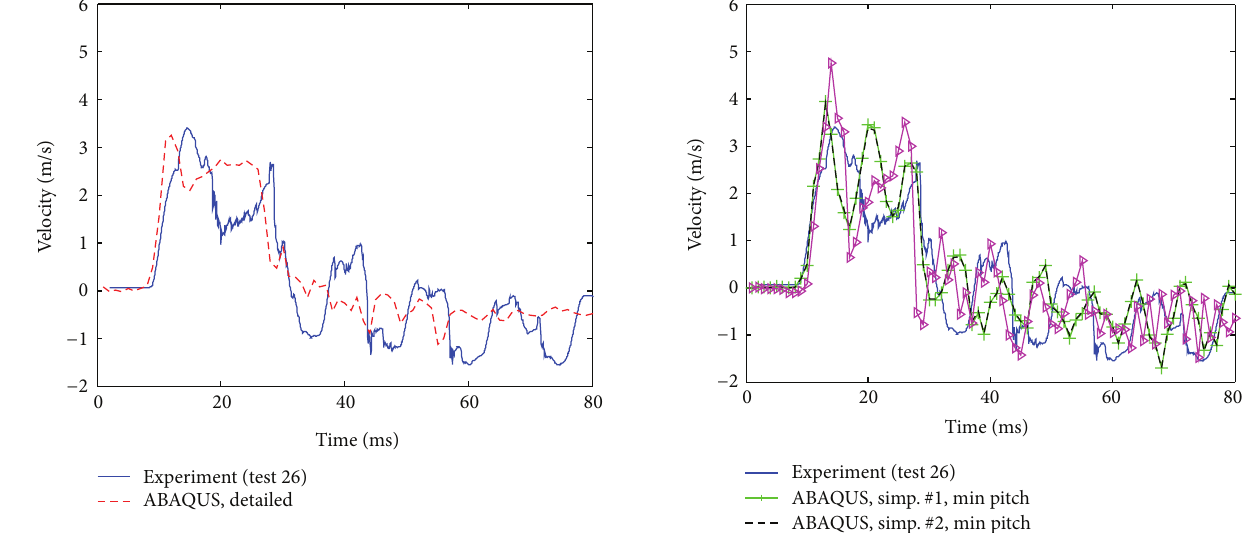
Figure 14: Velocity results for dynamic tension test, detailed model.